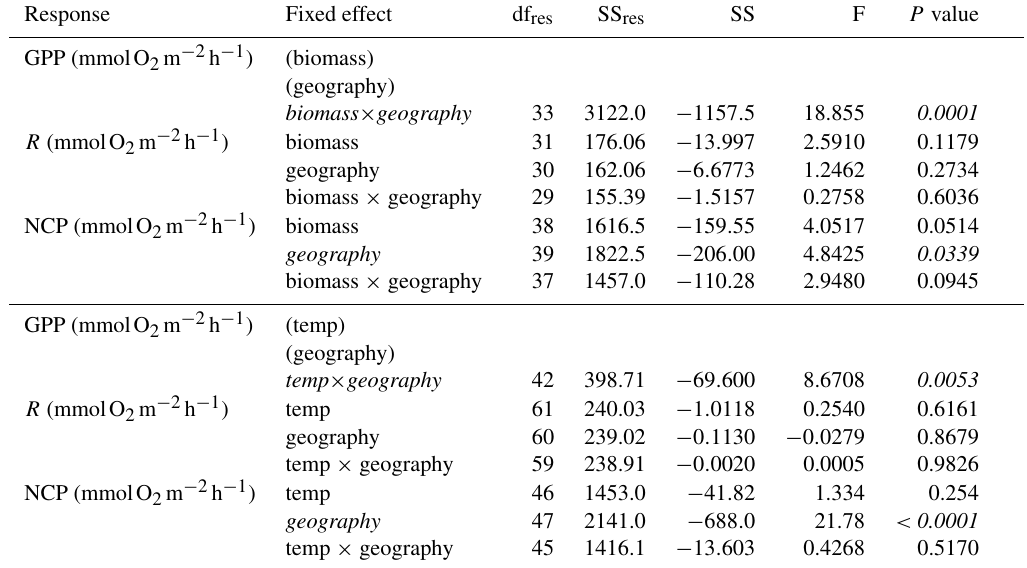
Table 3. Statistics for mixed-effects models of the residuals of the hourly metabolic rates as a function of biomass or temperature and geography and the